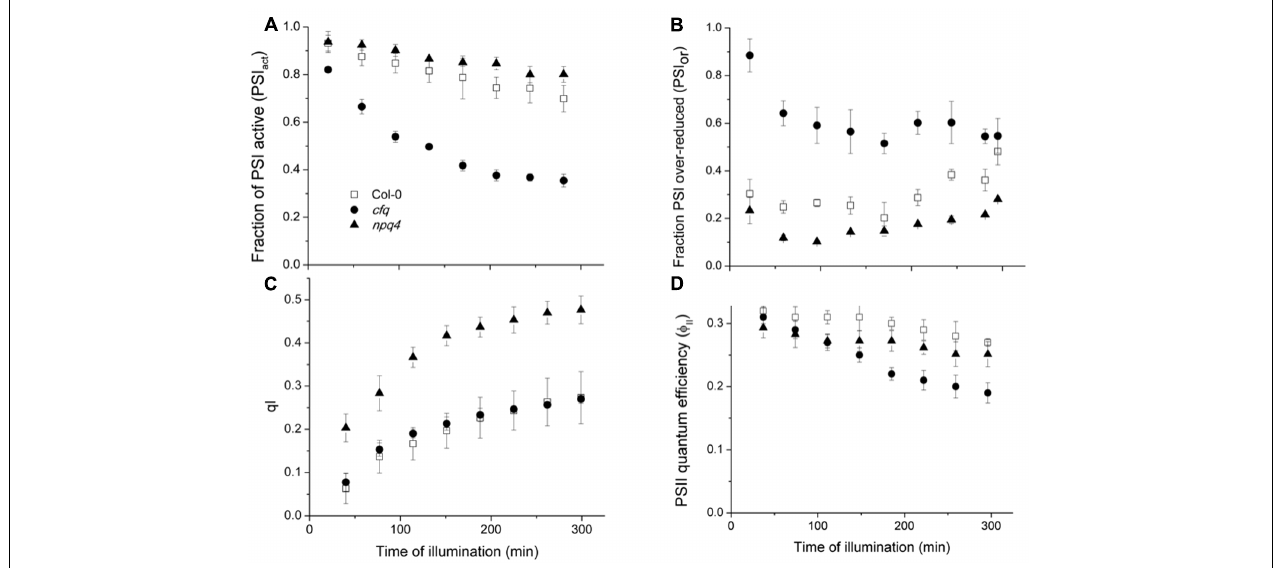
FIGURE 5 | Effects of illumination at low CO 2 on PSI and PSII. Attached leaves of Col-0 (open squares), cfq (closed circles) and npq4 (closed triangles) were illuminated with 300 µ mol photons · m − 2 · s − 1 under 50 ppm CO 2 . Data are plotted as a function of time of illumination. (A) The fraction of active PSI (PSI act ); (B) fraction of over-reduced PSI centers (PSI or ); (C) PSII photoinhibition (q I ); (D) PSII quantum efficiency ( φ II